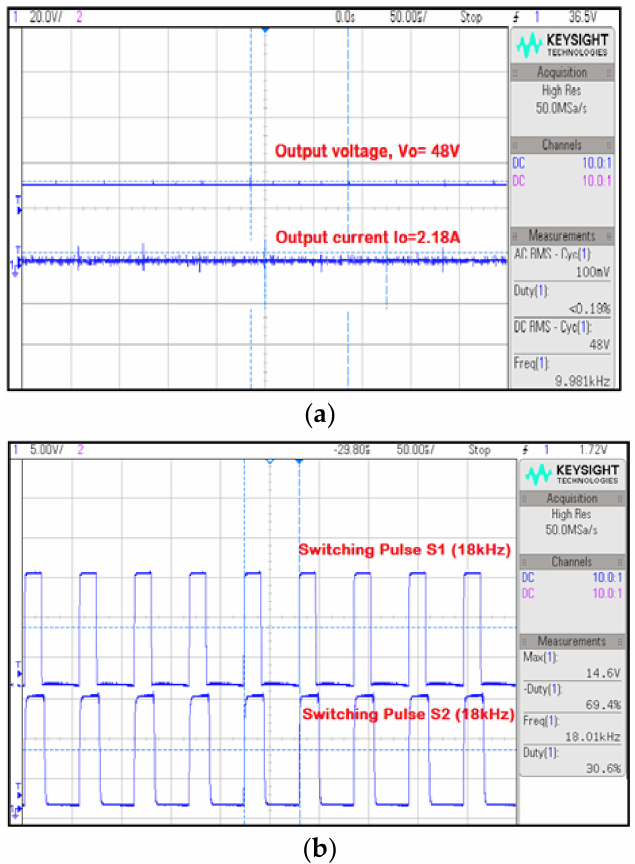
Figure 13. ( a ) Output voltage and output current; ( b ) switching pulses.